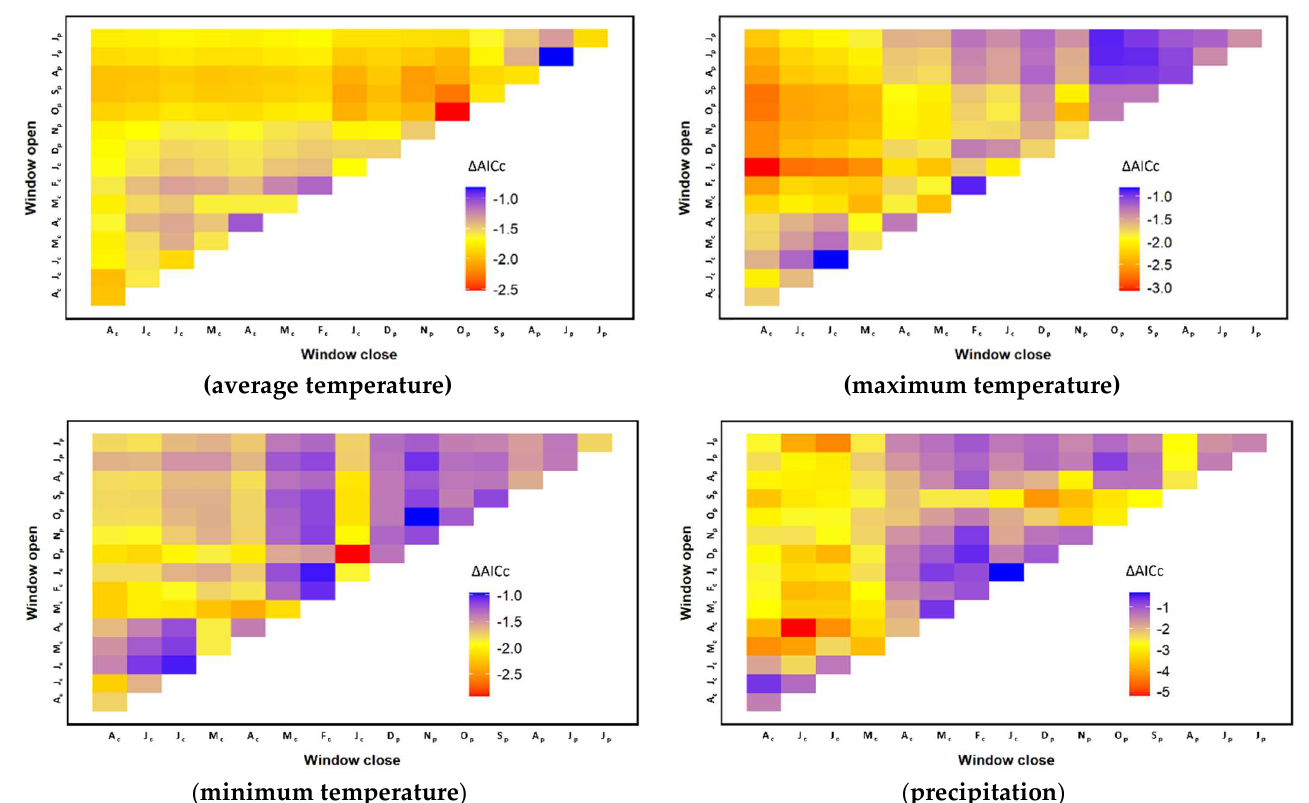
Figure 4. The most appropriate windows (starting and ending months) of climate variables for explaining tree ring growth. The most appropriate window was selected based on the smallest difference in the corrected Akaike Information Criterion (AIC c ) value. The vertical axis represents the starting month of the window while the horizontal one expresses the ending month. The capital letters on the axes are the first letters of the months. The subscripts following the capital letters depict the years relative to the growing season with ‘c’ and ‘p’ denoting the current and previous years, respectively.